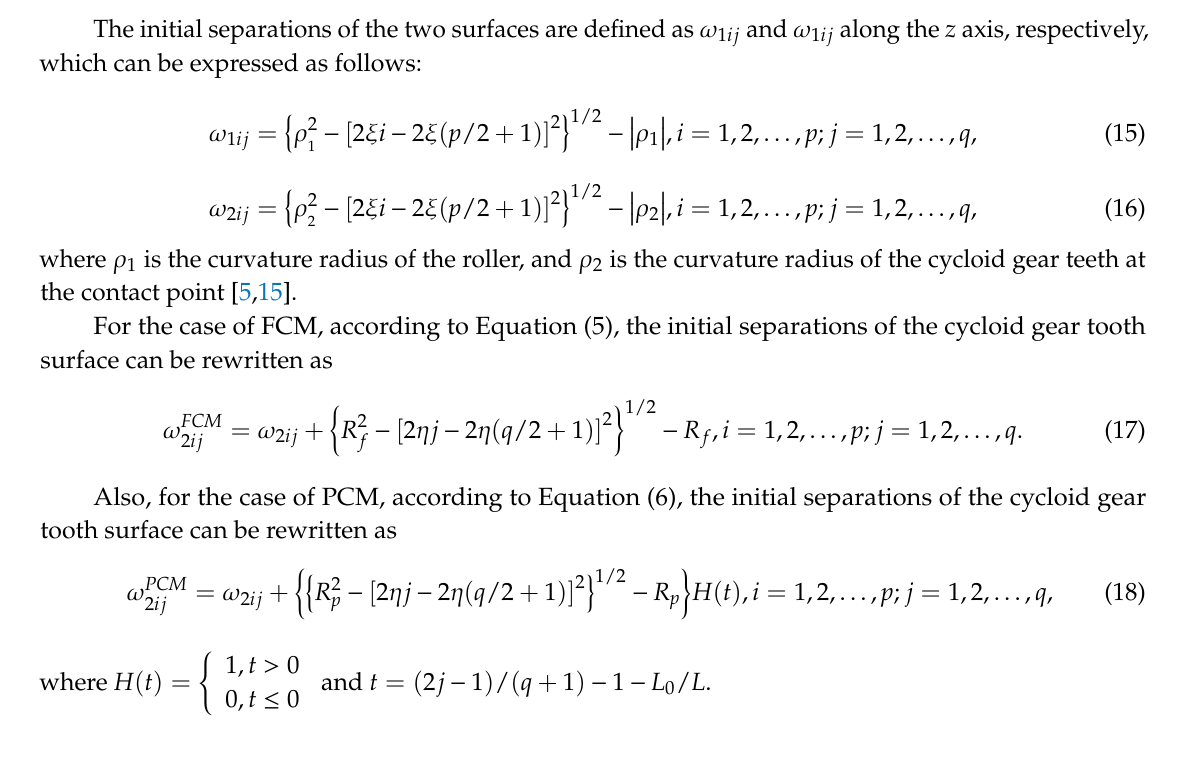
Figure 7. ( a ) Side view of the initial contact region, ( b ) contact of a tooth pair, and ( c ) discretization of the contact region into a grid.